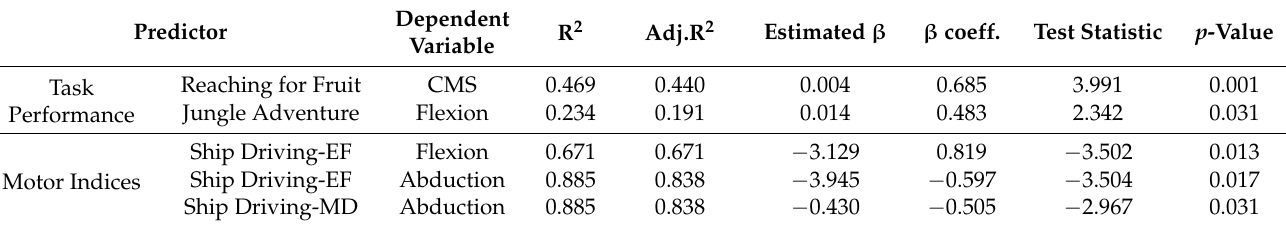
Table 12. The power of task performance and motor indices for predicting the clinical assessment results according to stepwise regression